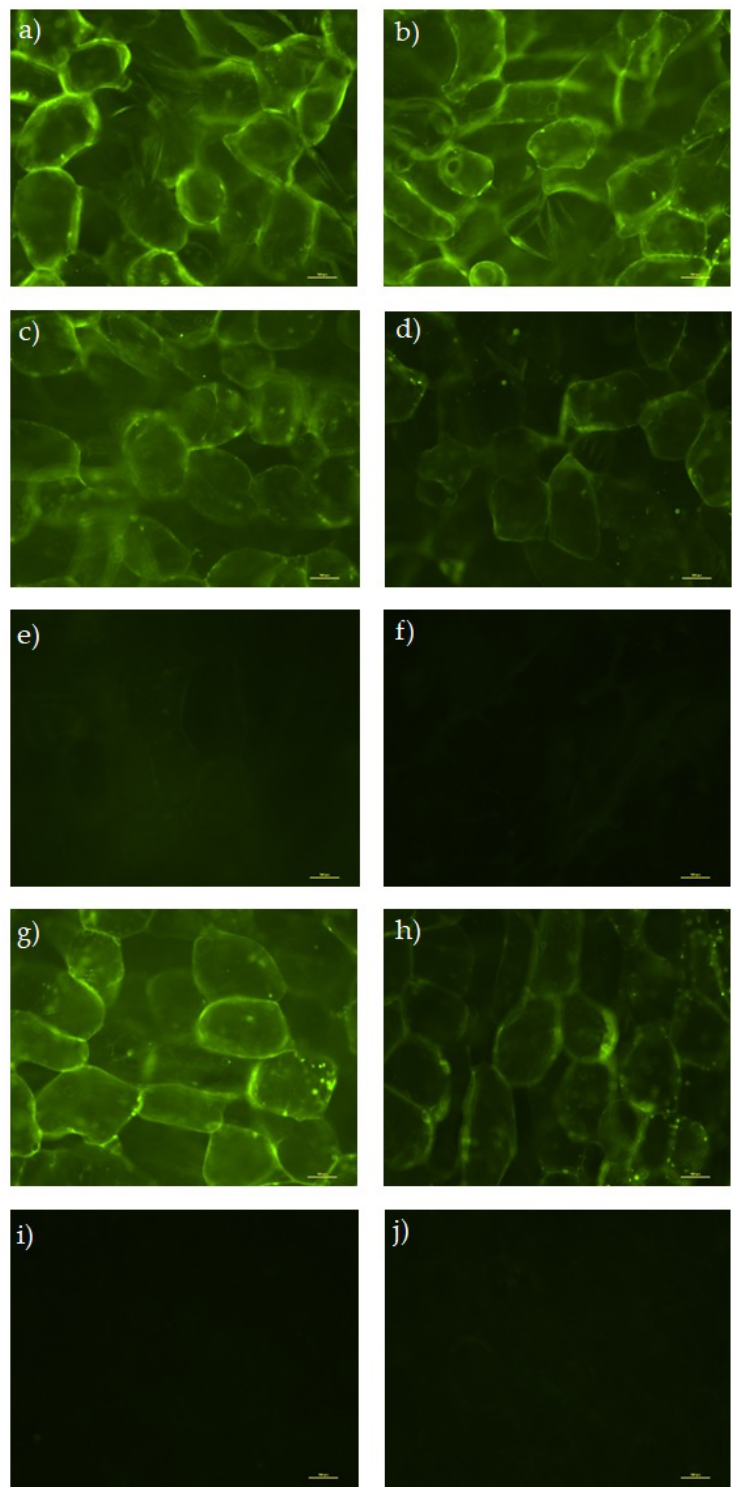
Figure 4. Cell viability of parenchyma apple tissue stained with FDA after vacuum impregnation and 24 h storage. ( a ) Fresh at 0 h, ( b ) fresh at 24 h, ( c ) VI at 0 h, ( d ) VI at 24 h, ( e ) AA at 0 h, ( f ) AA at 24 h, ( g ) CaLac at 0 h, ( h ) CaLac at 24 h, ( i ) AA+CaLac at 0 h, and ( j ) AA+CaLac at 24 h. Fresh, control sample; VI, vacuum impregnated with isotonic solution; AA, VI with ascorbic acid; Ca-Lac, VI with calcium lactate; AA+CaLac, VI with